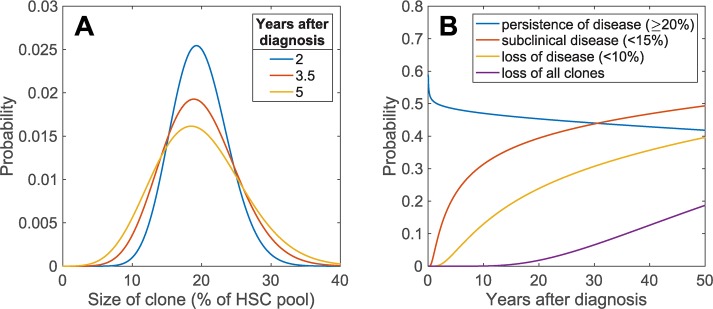
A. The size probability distribution for an established clone multiple years after diagnosis (20%). Being a one hump function, the distribution is asymmetric, stretching further to the right (larger sizes, see main text for details). B. Probabilities for an established clone to recede or vanish after diagnosis (20%) over time.